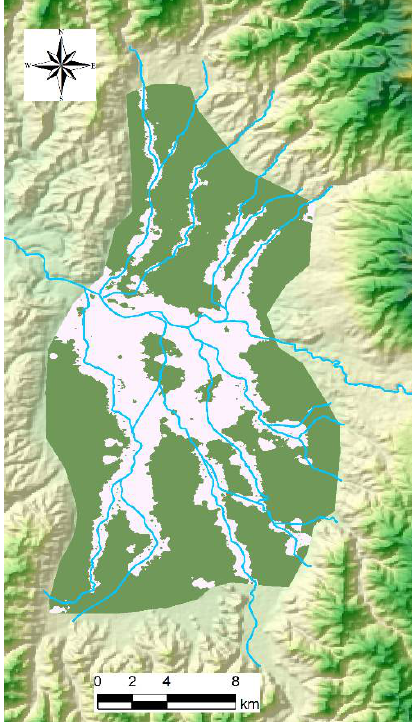
Figure 12. Distribution map of groundwater upflow areas (white areas). Reprinted by permission from Springer Customer Service Centre GmbH: Springer HYDROGEOLOGY JOURNAL